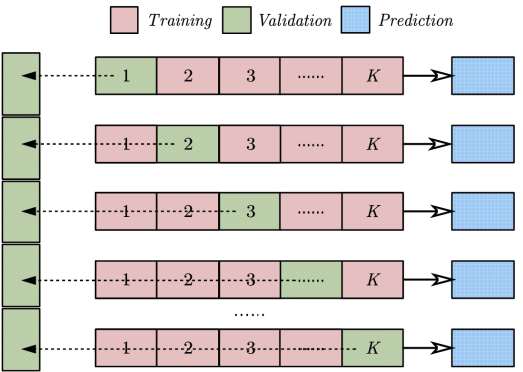
Figure 2. Diagram of the internal K-fold cross-validation process in stacking.